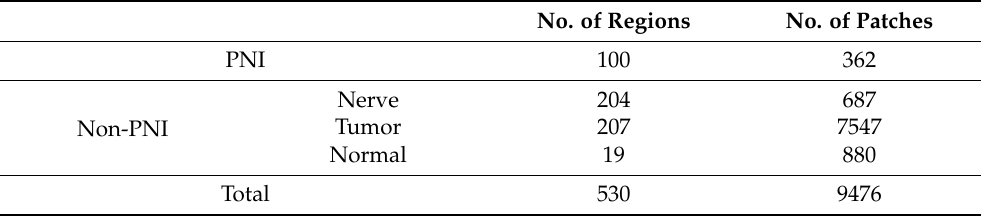
Table 1. Composition of regions and